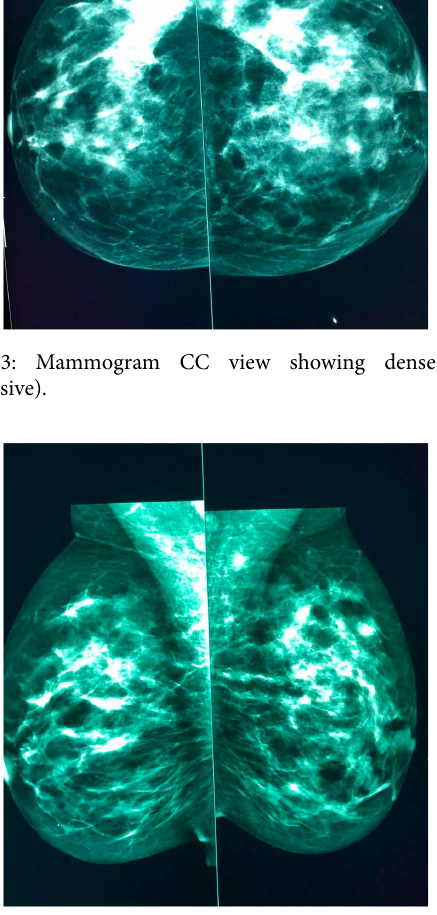
Figure 2: Post-spinal decompression and spinal fixation MRI.